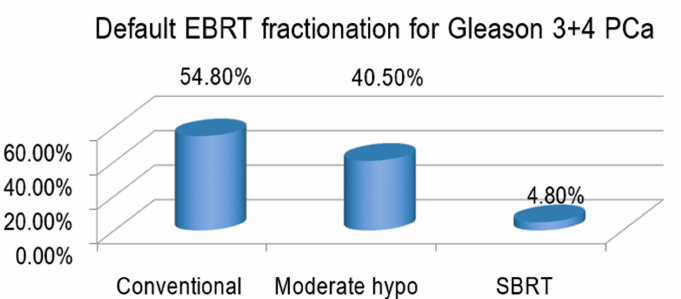
PCa = prostate cancer; hypo =